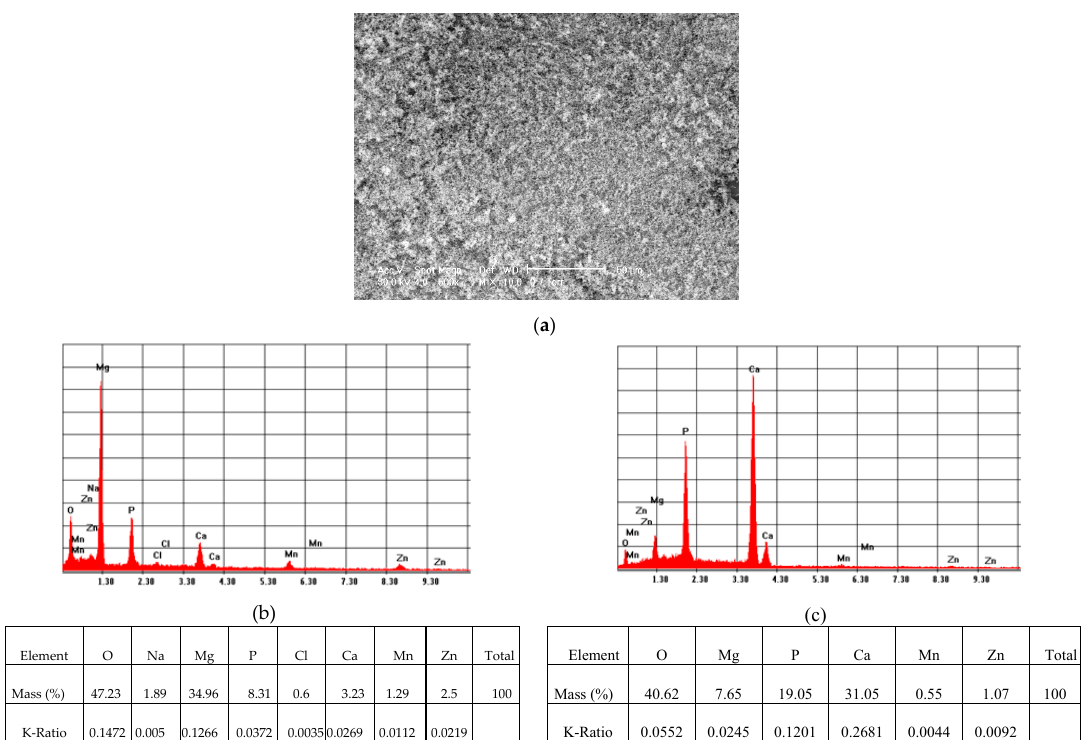
Figure 15. Representative SEM images (magnification 500×) of the HAP coated ZM21 sample ( a ), and corresponding EDS spectra ( b ) of corroded areas; ( c ) of uncorroded areas, after electrochemical corrosion in SBF.